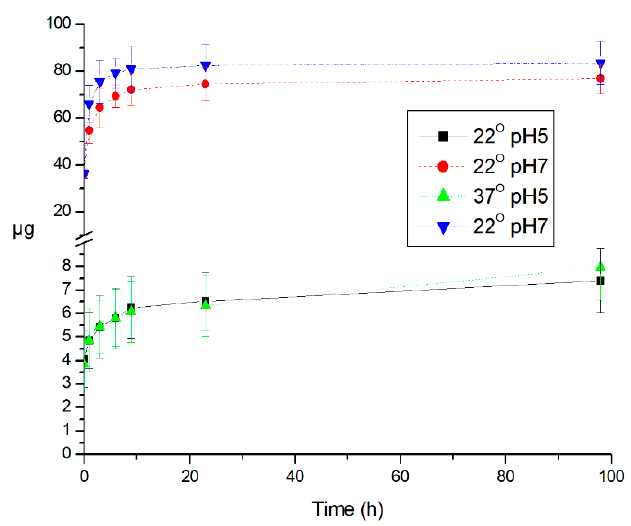
Figure 4. Dependence of the mass of FITC-labeled BSA in the supernatant on the incubation time of polyelectrolyte microcapsules, at room temperature (22 °C) and at 37 °C, at pH 5 and 7.